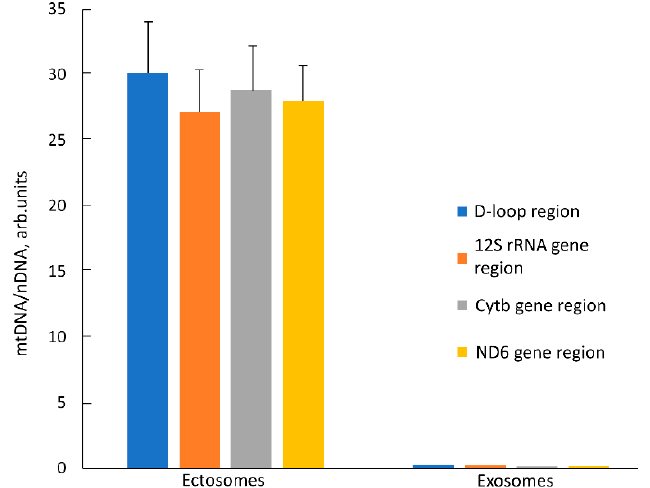
Figure 8. Relative mitochondrial DNA (mtDNA) content in ectosomes and exosomes. The ratio of mtDNA to nuclear DNA (nDNA) in intact MSC has been taken as 1. Four different components of mitochondrial DNA including non-coding region (D-loop) and three different gene regions were examined. Obvious enrichment of ectosomes with mitochondrial DNA (up to 30 fold) and corresponding depletion of mtDNA in exosomes (down to 0.3 fold) is shown.